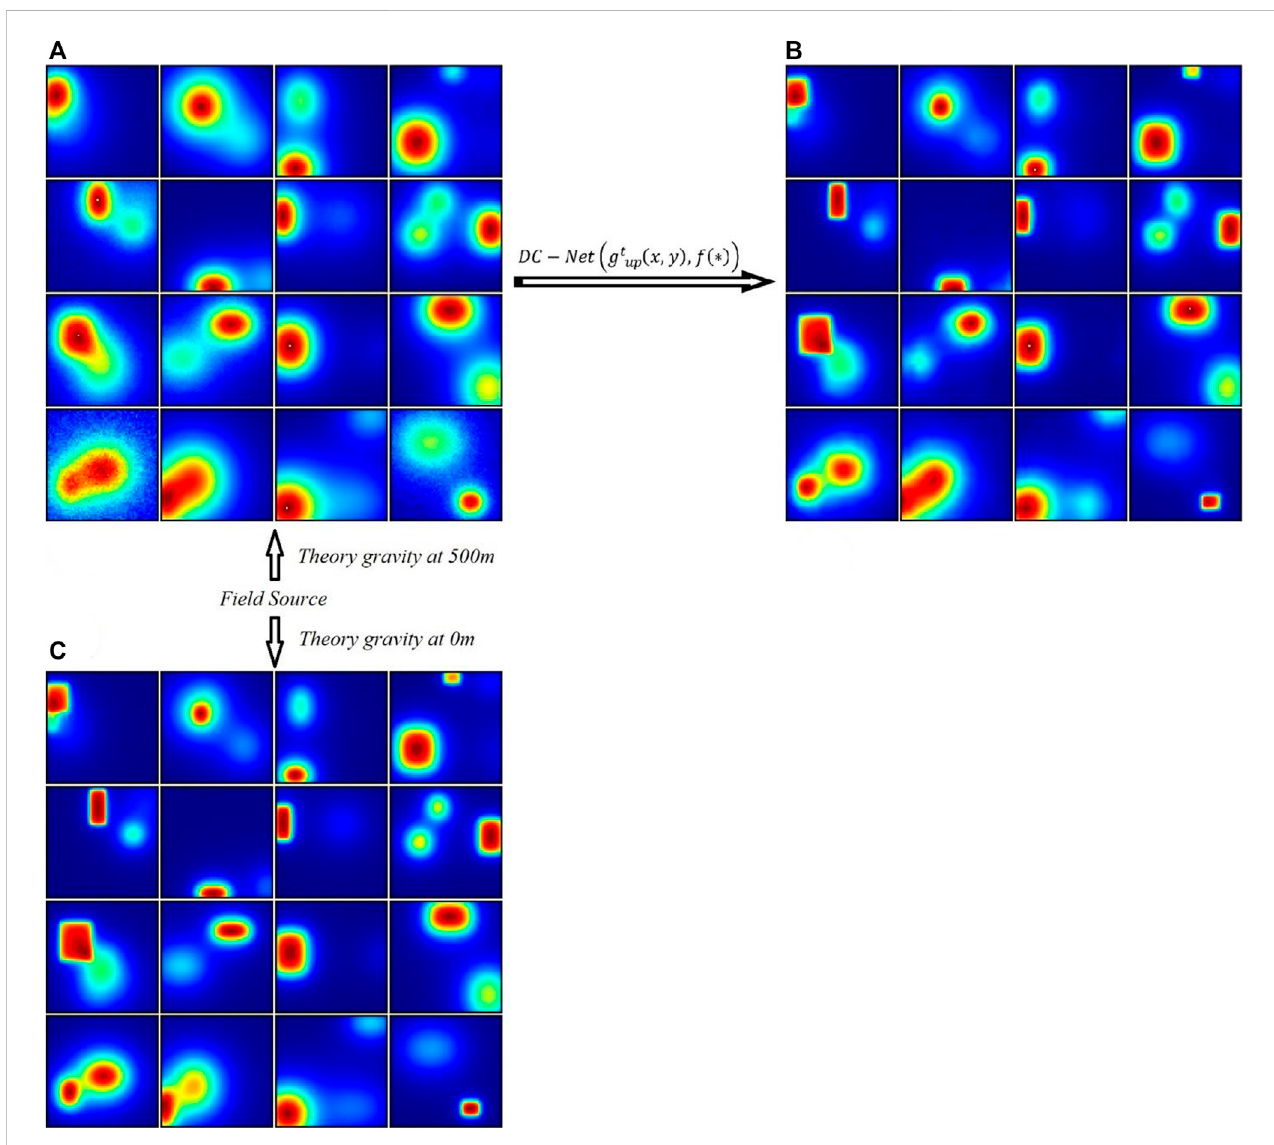
FIGURE 4 Validation dataset prediction effect display: (A) subset of thevalidation data composed of gravity anomaliesat500 m; (B) subset ofthe prediction results composed of gravity anomalies at 0 m; (C) true value of gravity anomalies at 0 m.